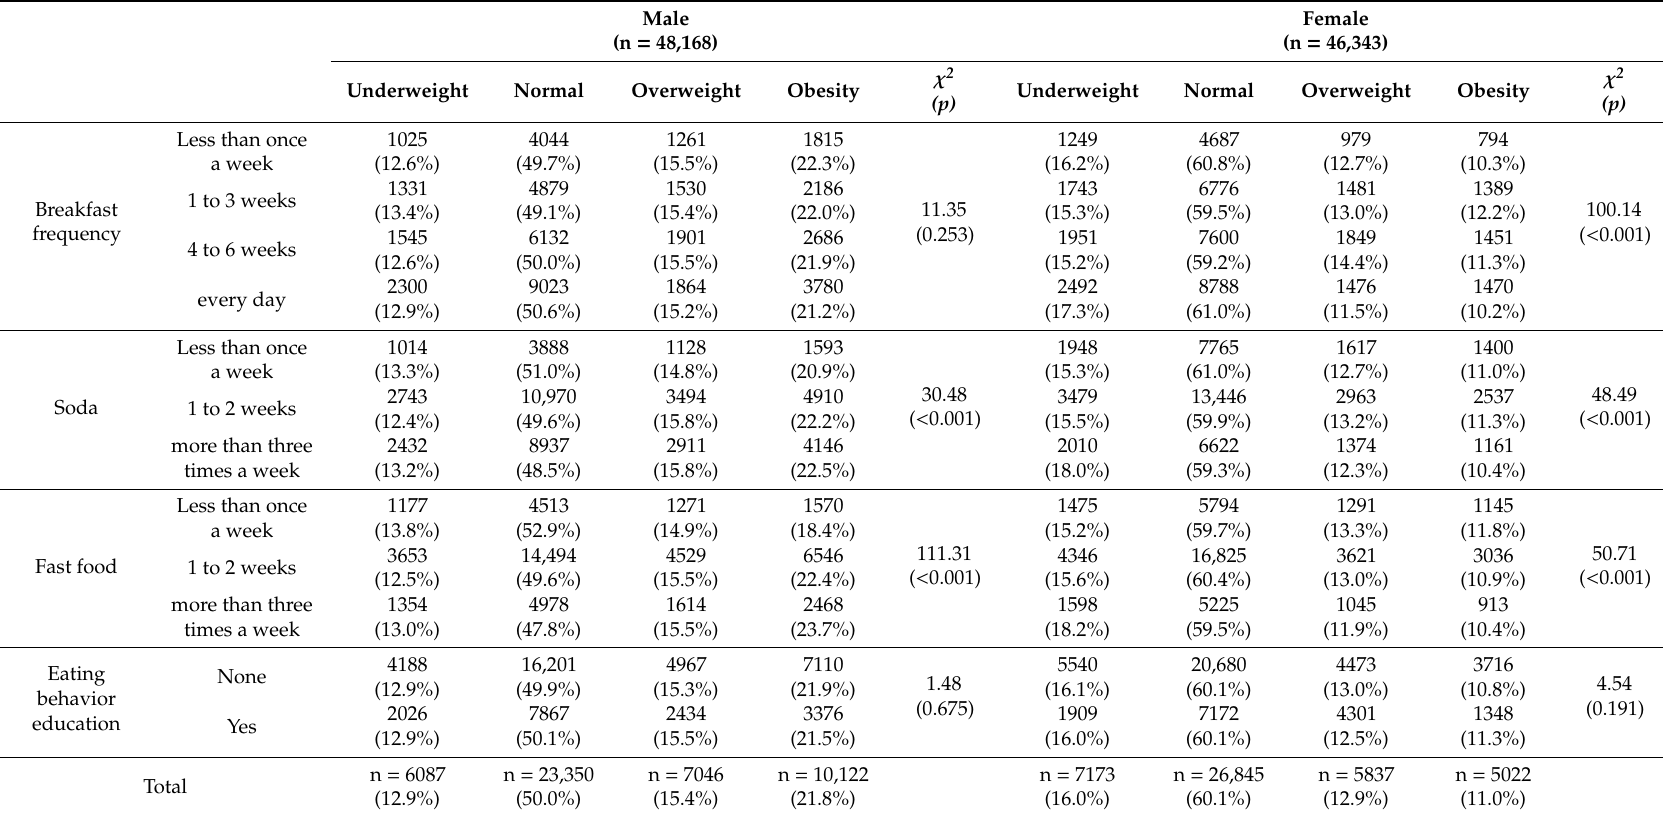
Table 3. Relationship between Eating Behavior and Youth